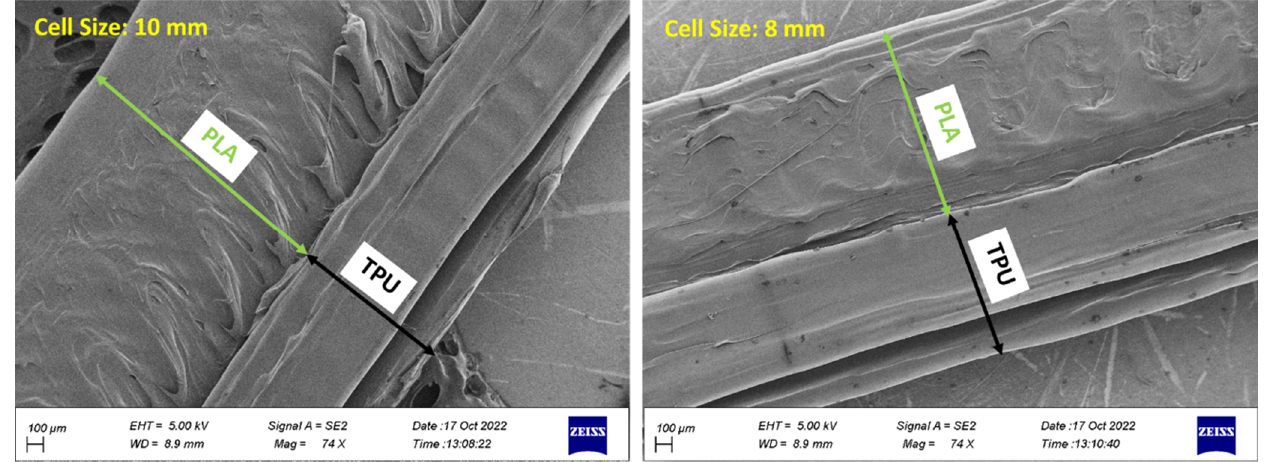
Figure 18. The FE-SEM image for connecting PLA/TPU materials.